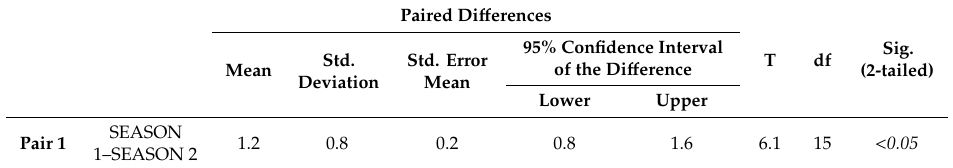
Table A4. Samples Test.